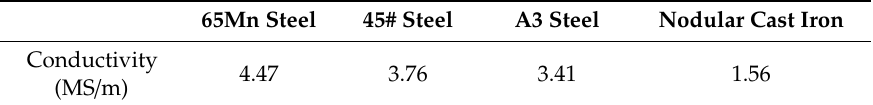
Table 1. Conductivity of experiment samples.